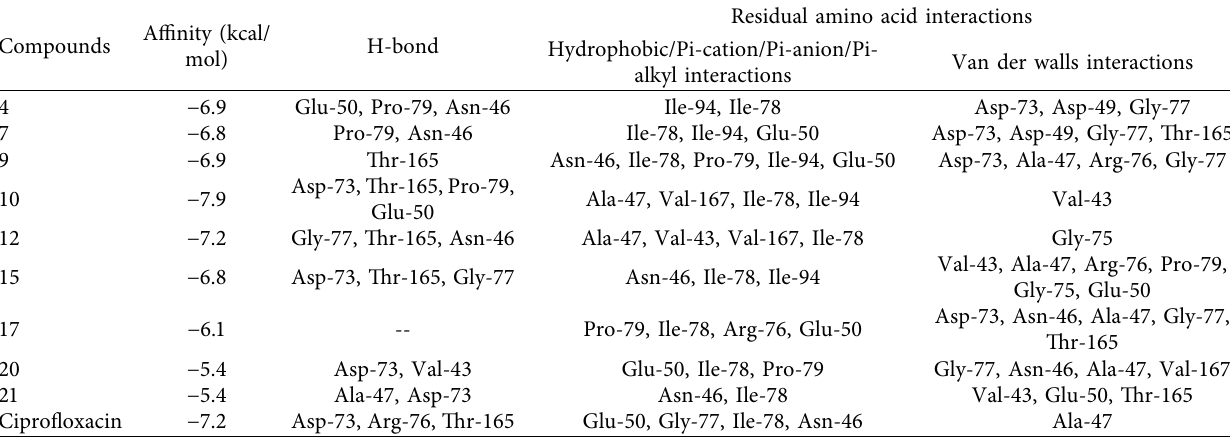
Table 3: Molecular docking value of synthetic compounds ( 4–21 ) against E. coli DNA gyrase B (PDB ID: 6F86).